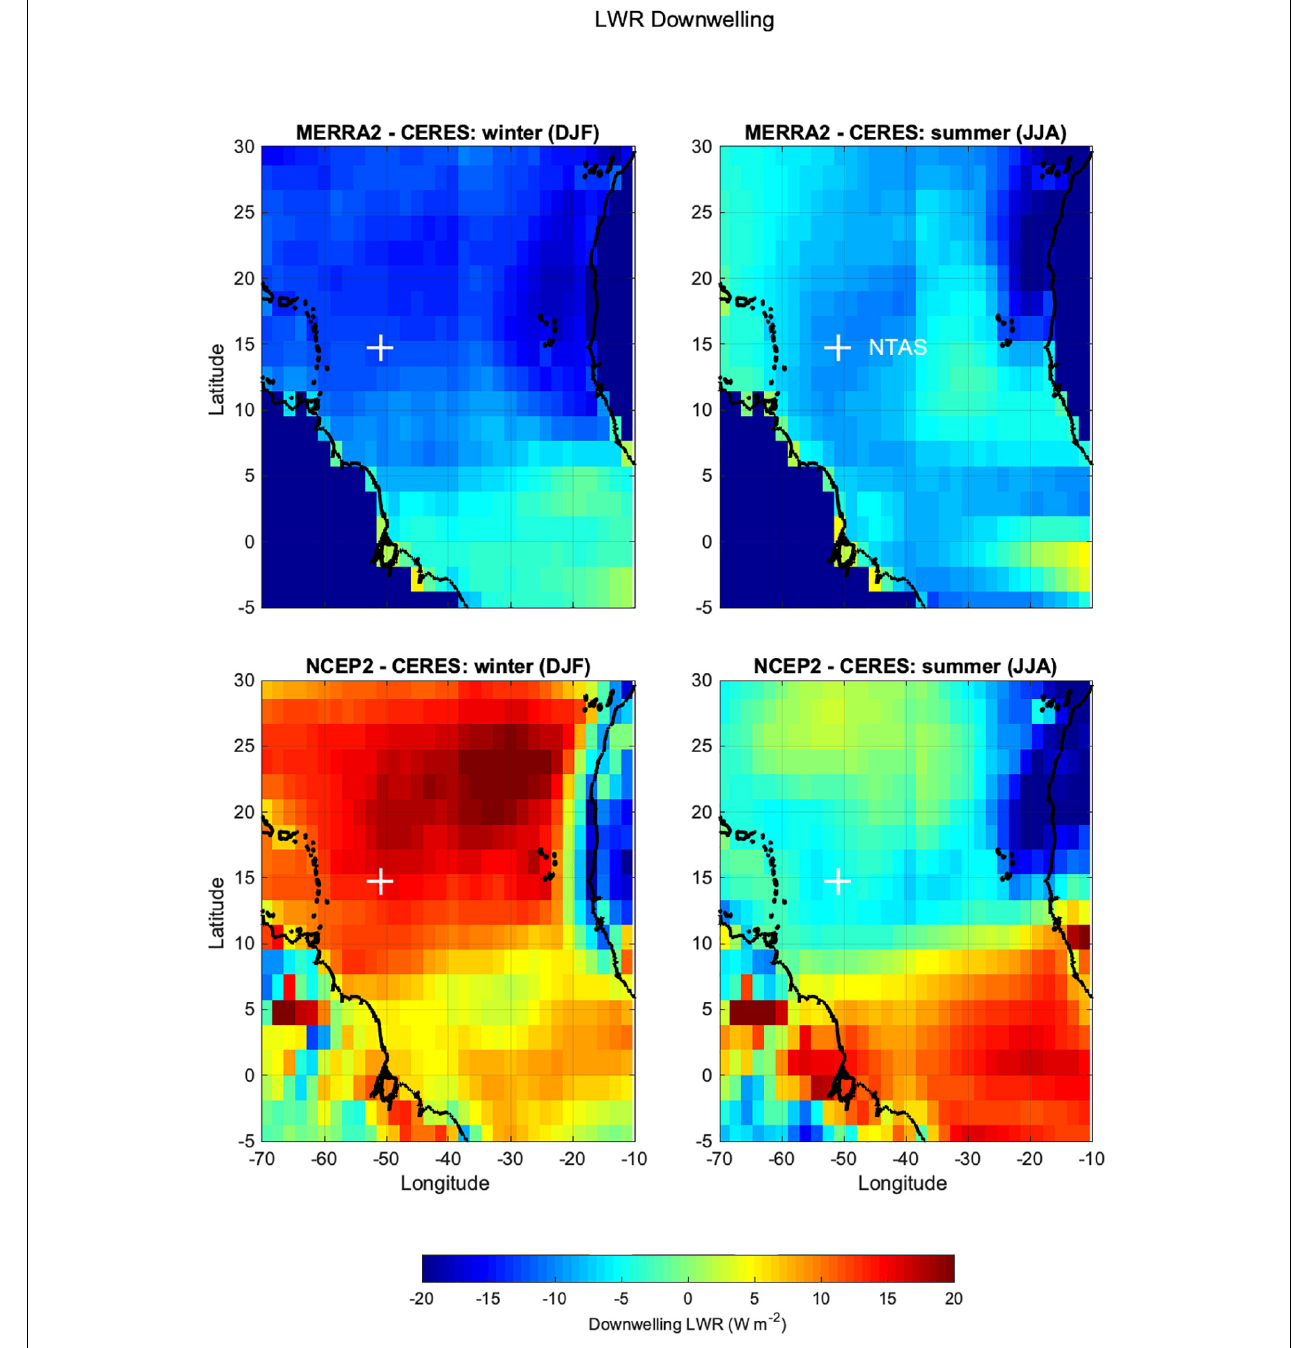
FIGURE 7 | Differences of climatological seasonal averages of downward longwave radiation. Left: winter (DJF), right: summer (JJA). Top MERRA-2 minus CERES, bottom: NCEP-2 minus CERES. MERRA-2 and CERES were interpolated to the NCEP-2 spatial grid.